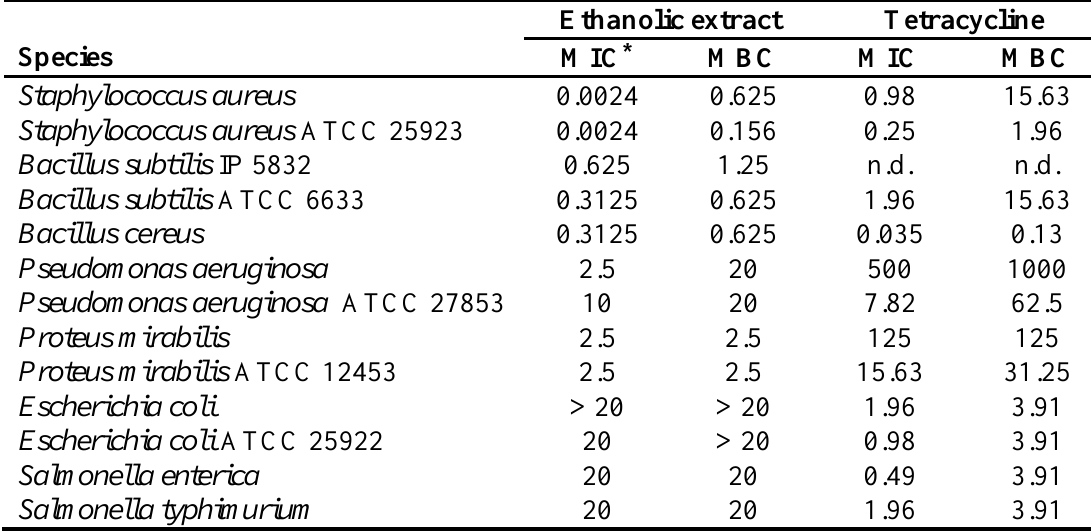
*Minimum inhibitory concentration (MIC) and minimum bactericidal concentration (MBC) values are given as mg/ml for extract and µ g/ml for antibiotic; n.d. - not